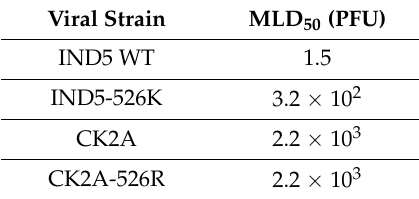
Table 1. Determination of the MLD 50 of RG